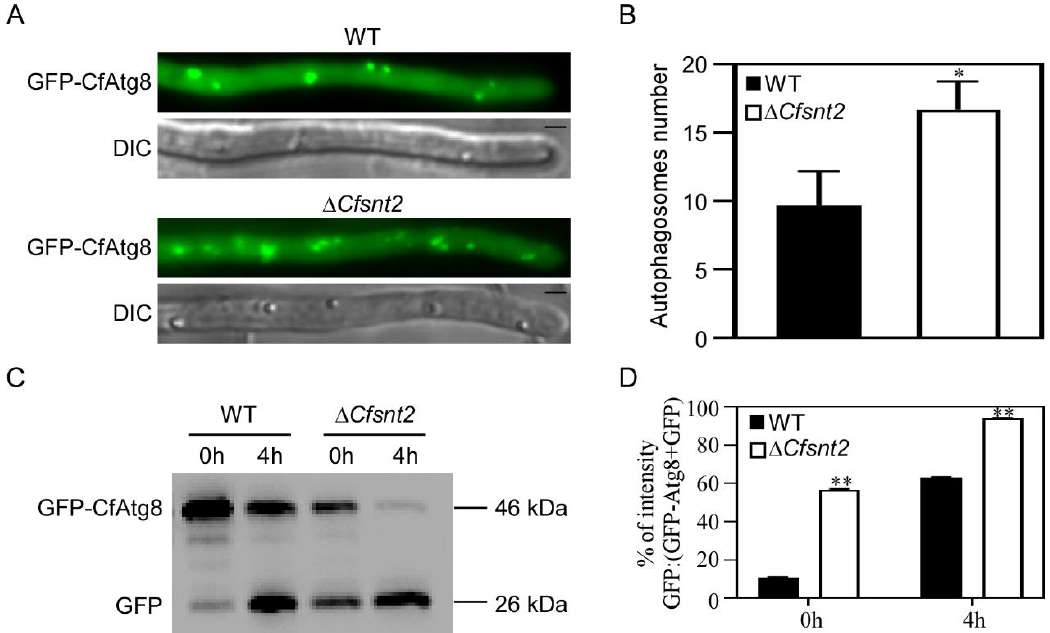
Figure 7. CfSnt2 negatively regulates autophagy. ( A ) Fluorescent micrographs of autophagosomes in WT and Δ Cfsnt2 mutant. Strains expressing the GFP-CfATG8 in WT and Δ Cfsnt2 mutant were observed by fluorescent microscopy. Bar = 5 μm. ( B ) Statistical analysis of autophagosome numbers in hyphal tips. Error bars indicate SD and asterisk represents significant differences (* p < 0.05). ( C ) Immunoblot analysis of GFP-CfAtg8 proteolysis. Strains expressing the GFP-CfATG8 in WT and Δ Cfsnt2 mutant were cultured in MM-N for 4 h, and the mycelial proteins were extracted and immunoblotted with anti-GFP antibody. ( D ) Relative intensity of GFP/(GFP-CfAtg8 + GFP) ratios. Asterisks represent significant differences (** p < 0.01).